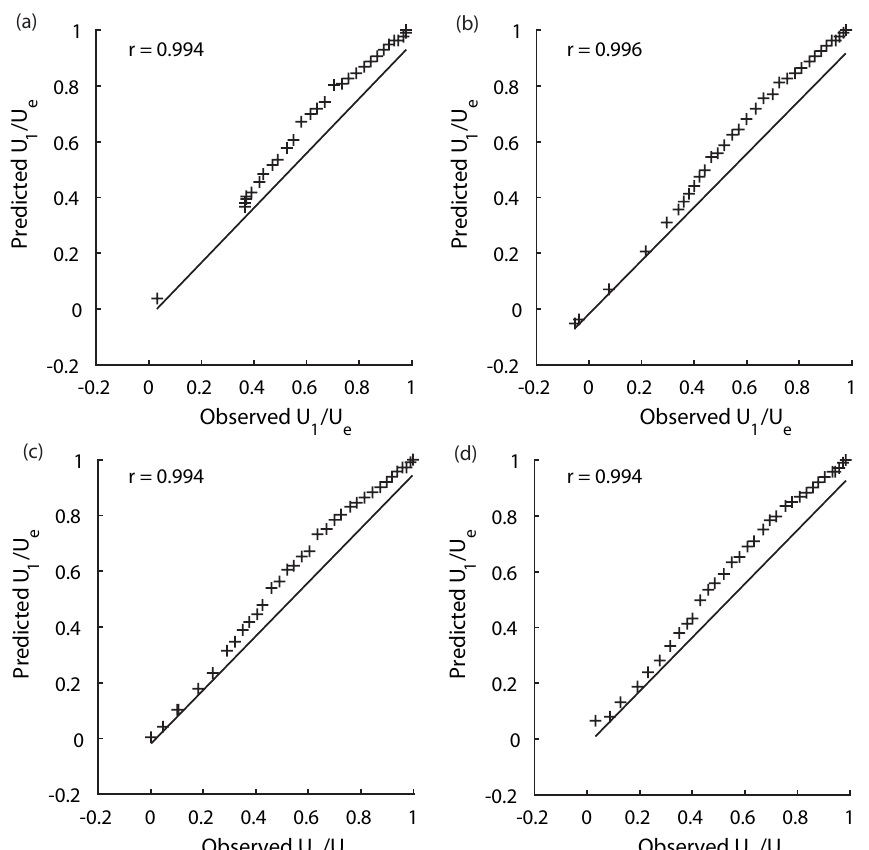
Figure 8. Comparison of vertical profiles of predicted mean-flow velocity U 1 for Run 4 with available observations [13] at four locations: ( a ) x 1 / λ ≈ 4.5, ( b ) x 1 λ ≈ 4.75, ( c ) x 1 / λ ≈ 5, and ( d ) x 1 / λ ≈ 5.25. The locations are in the channel center-plane (at x 3 = 0.0375